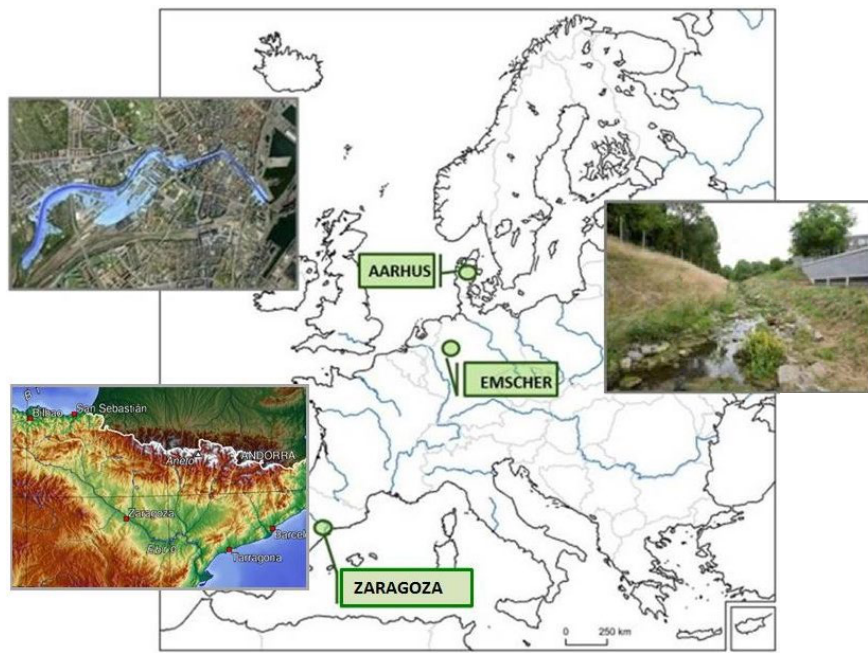
Figure 1. Map of the three case studies. Table 2. Overview of interviews performed in the case-studies.